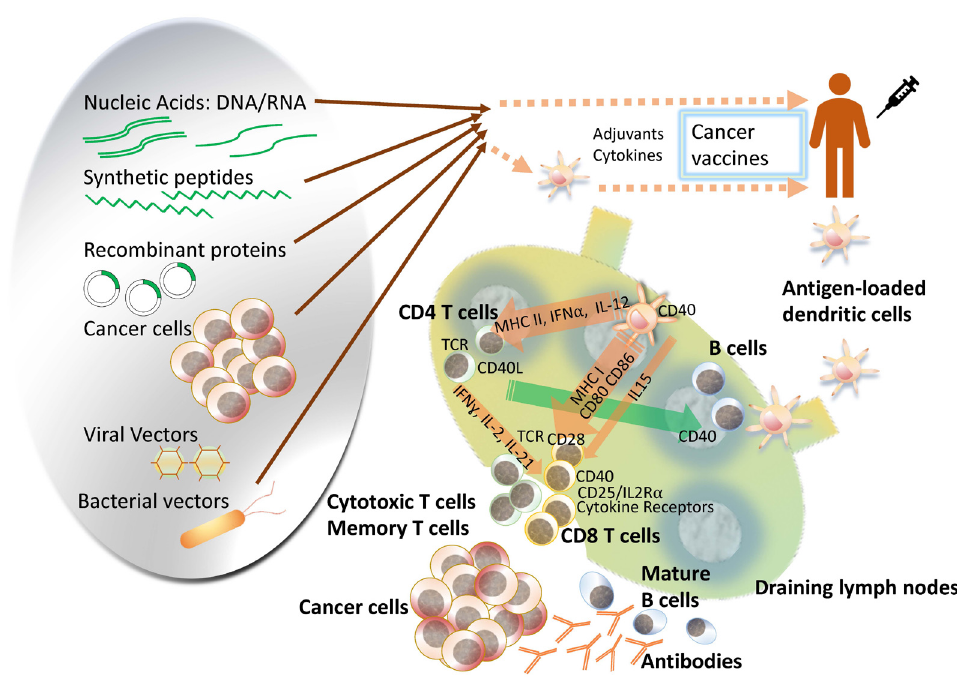
Figure 1. Cancer vaccine platforms and interactions in the immune system. Antigen-specific cancer vaccines come in a variety of compositions to deliver the tumor antigen of interest. Compared with cell-based vaccines, the rest of the platforms have the merit of potential for simpler manufacturing and flexibility in delivery of the vaccines along with special features of individual platforms. Cell-based vaccines, as represented by dendritic cell (DC) vaccines, have an advantage in that investigators can perform targeted loading of the antigen of interest, circumvent poor DC maturation in patients with cancer, and manipulate in vivo , but standardizing the manufacturing and quality assessment is another hurdle to surmount. As the network of the immune system is unveiled further, more efficient and intelligent design of cancer vaccine platforms will expand the territory to use these either by themselves or in combination with other cancer therapy options in this era in which cancer immunotherapy has become the fourth pillar in oncology, beyond surgery, chemotherapy, and radiation. IFN, interferon; IL, interleukin; MHC, major histocompatibility complex; TCR, T-cell